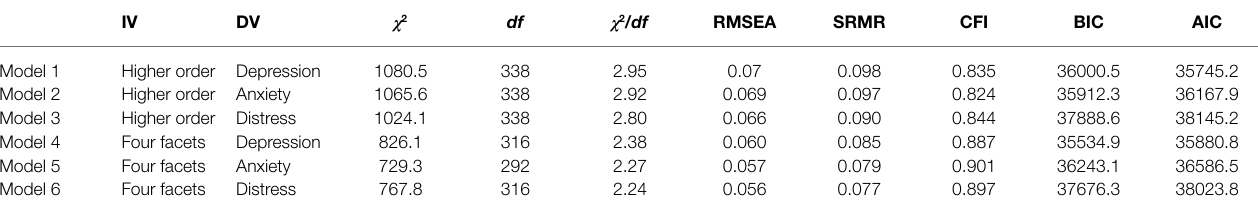
TABLE 2 | Fit indices among the four-factor models